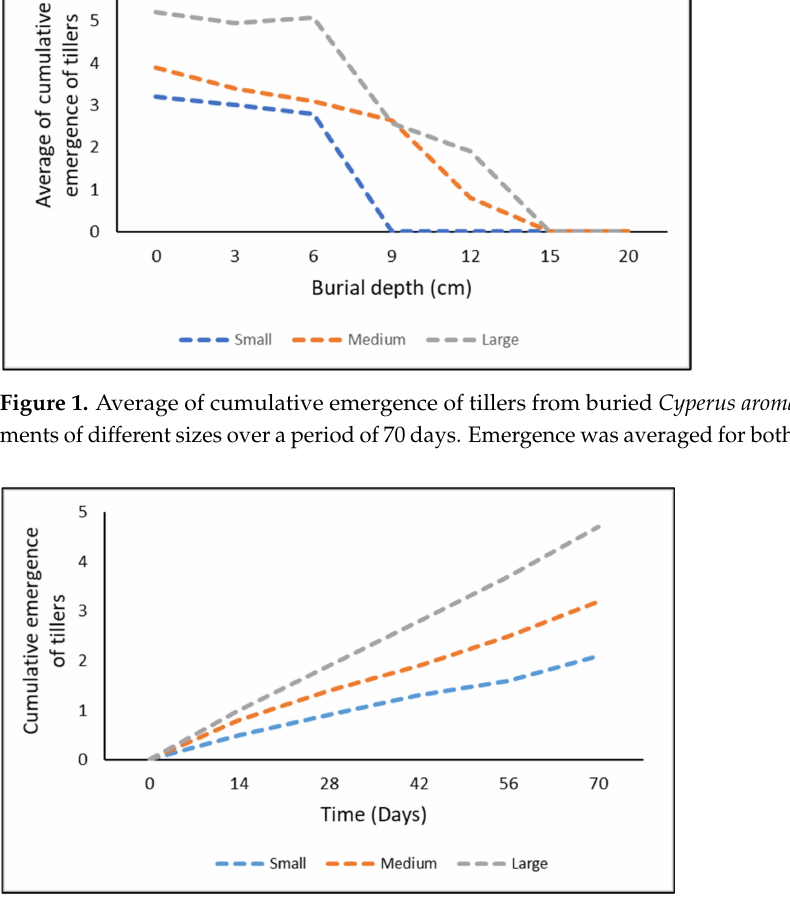
Figure 2. Cumulative emergence from buried Cyperus aromaticus rhizome fragments of different sizes over a period of 70 days. Emergence was averaged for all the burial depths and both the soil types used.